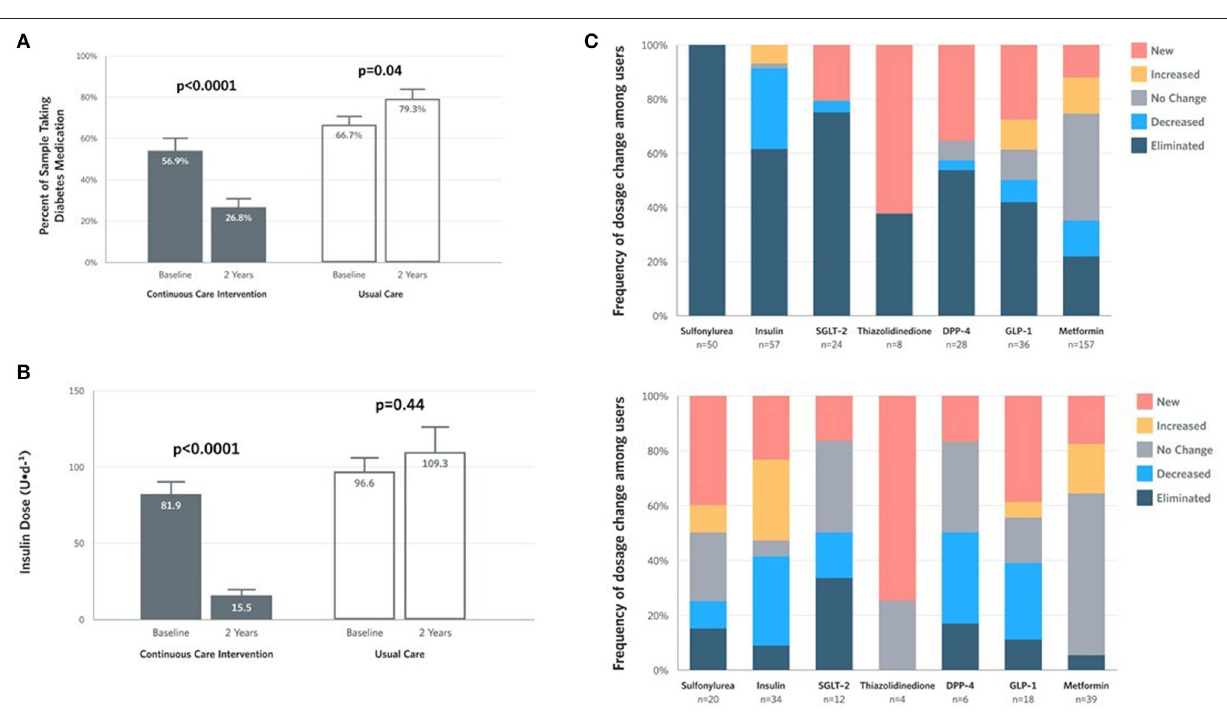
FIGURE 3 | Medication and insulin dose changes from baseline to 2 years for CCI and UC group completers. (A) Percent of completers taking diabetes medications, excluding metformin. (B) Mean ± SE prescribed insulin dose among baseline users. (C) Frequency of medication dosage and use change among prescribed users by diabetes medication